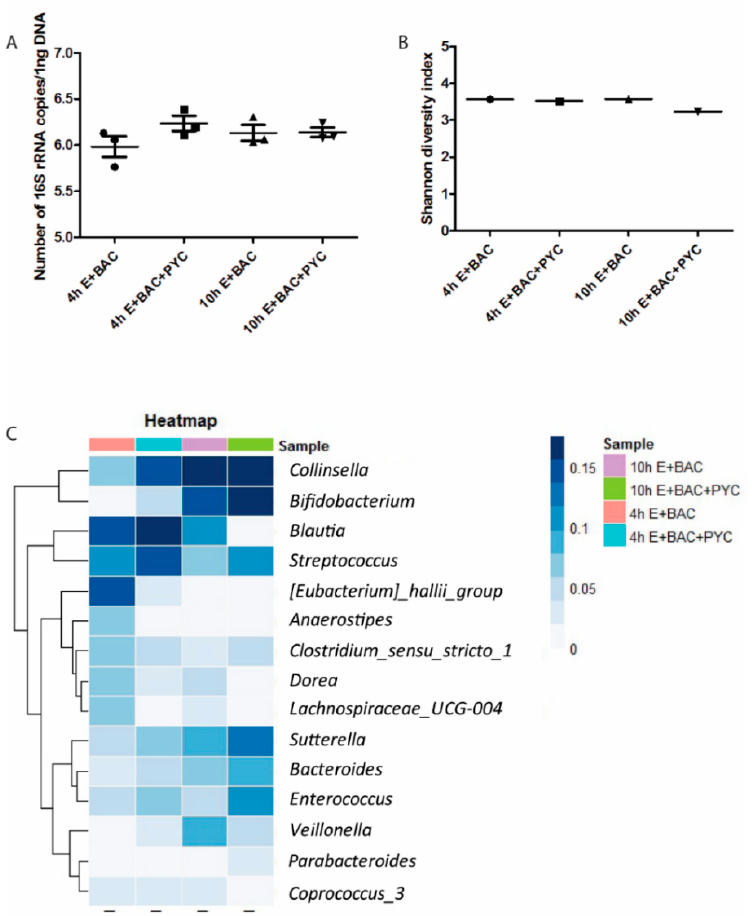
Figure 8. PYC metabolites modulate microbiota composition. ( A ) Absolute abundance of total bacteria present in the four samples, determined by quantitative polymerase chain reaction (qPCR), with total counts log 10 transformed. ( B ) Alpha diversity of the four samples calculated using the Shannon diversity index, which accounts for both evenness and richness of a community. ( C ) Heatmap representing the relative abundances of the fifteen most abundantly present bacterialgenera. E: enzymes; BAC: intestinal bacteria (human faecal suspension). In A, mean and SD are shown of n = 3 independent